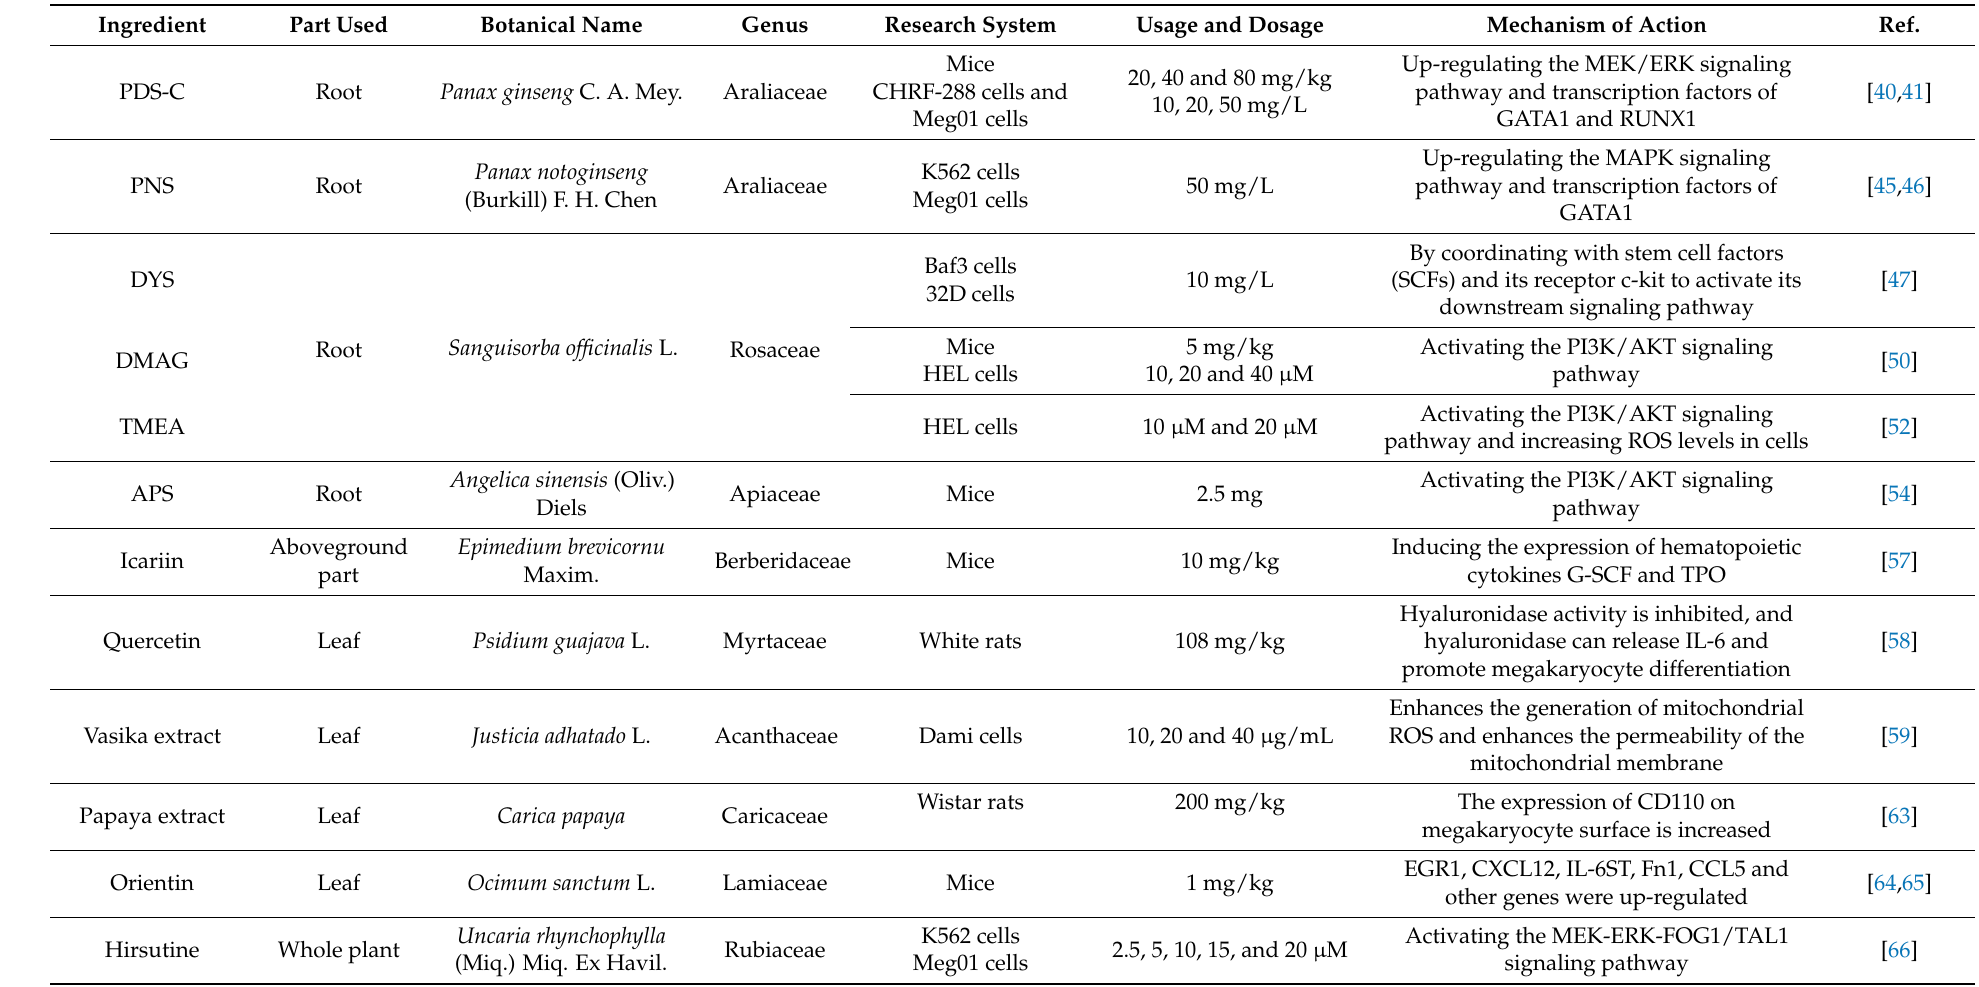
Table 1. Targeting and signaling pathways related to megakaryocyte differentiation by botanical drug active components in vitro and in